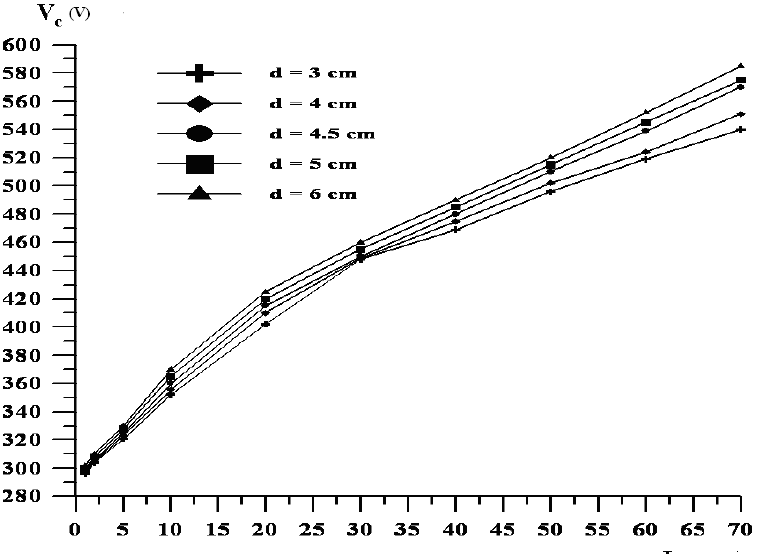
Fig. 2: Mapping of magnetic flux for a- radial distribution. b-axial distribution.